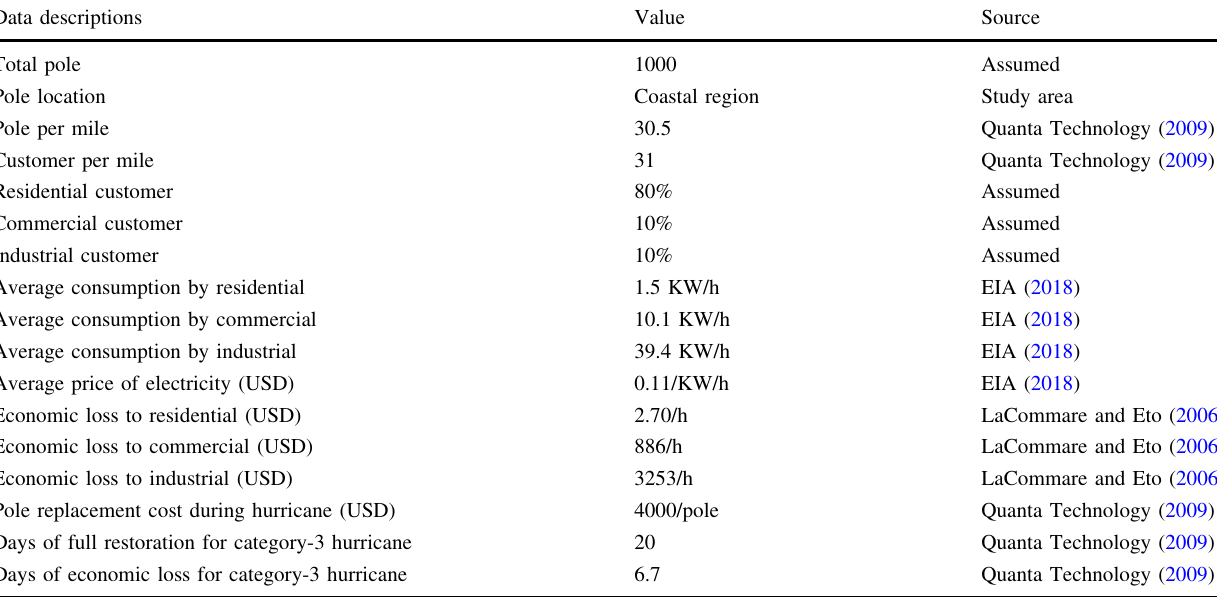
Table 5 The cost–benefit analysis data sources